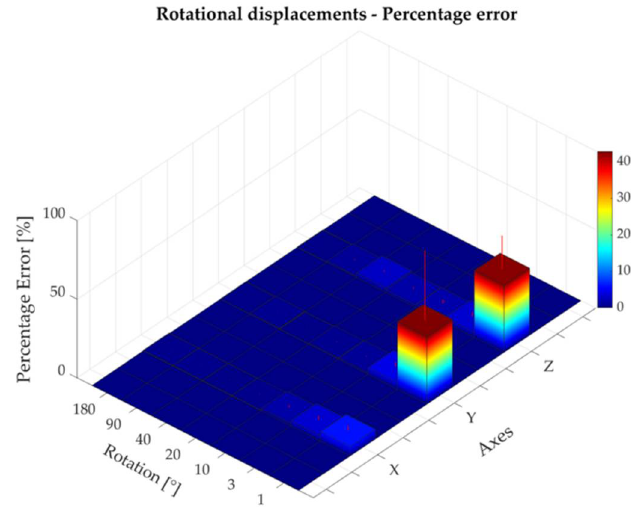
Figure 10. The percentage error corresponding to rotational displacements around the x-, y-, and z-axes.